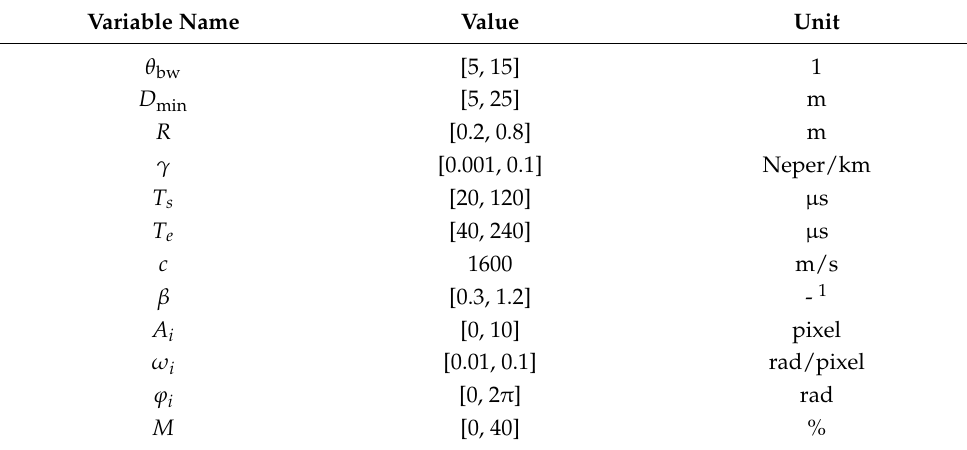
Table 1. Variable values used in sample